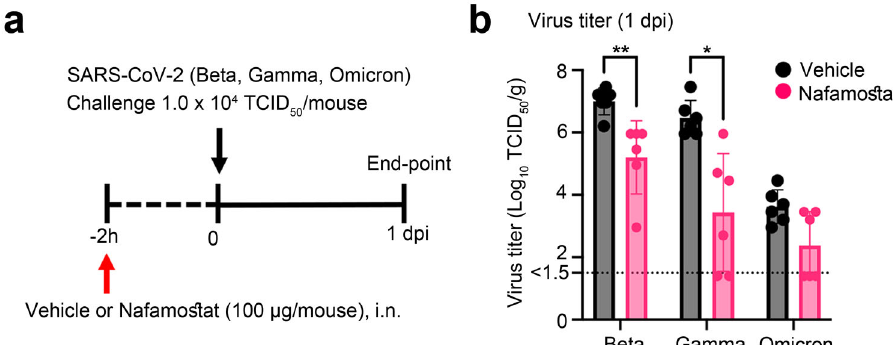
Fig.4|EffectofnafamostatonexperimentalinfectionofWTmicewithvarious SARS-CoV-2strains.a Schematicoftheexperimentalprotocol.C57BL/6micewere treated intranasally with nafamostat (100 µ g/head) and 2hours later, they were infectedwithBeta,aGammaandanOmicronvariantofSARS-CoV-2(1×10 4 TCID 50